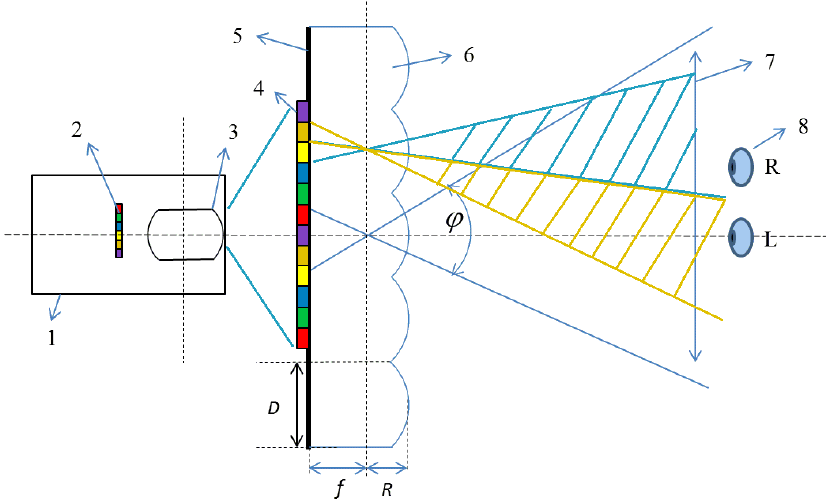
Figure 1. Schematic view of projector-based 3D display system: 1—projector; 2—display element; 3—projection lens; 4—elemental image; 5—diffuser layer; 6—lenticular lens; 7—viewing zone; 8—observer. The shaded areas show different areas of vision. Adapted from [15].